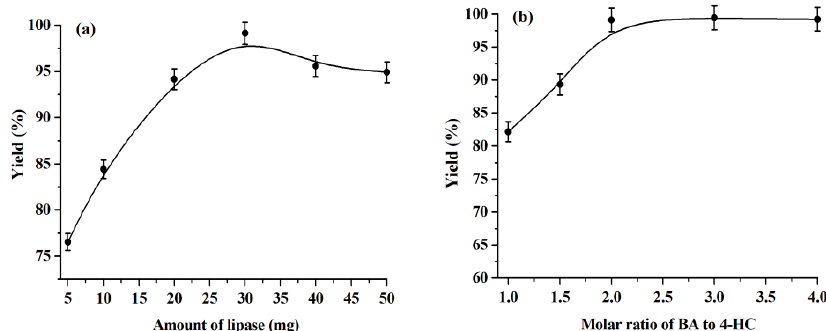
Figure 4. Influence of enzyme dosage ( a ) and molar ratio of BA to 4-HC ( b ). Reaction conditions: ( a ) BA, 1.0 mmol, water, 0.1 mL, temperature, 50 °C, 4-HC, 0.5 mmol, reaction time, 168 h, 1.0 mmol, water, 0.1 mL, temperature, 50 ◦ C, 4-HC, 0.5 mmol, reaction time, 168 h, [C 1 C 3 OHim]NTf 2 , [C 1 C 3 OHim]NTf 2 , 0.5 g. ( b ) Water, 0.1 mL, temperature, 50 °C, lipase, 30 mg, 4-HC, 0.5 mmol, reaction 0.5 g. ( b ) Water, 0.1 mL, temperature, 50 ◦ C, lipase, 30 mg, 4-HC, 0.5 mmol, reaction time, 168 time, 168 ho, [C 1 C 3 OHim]NTf 2 , 0.5 g.